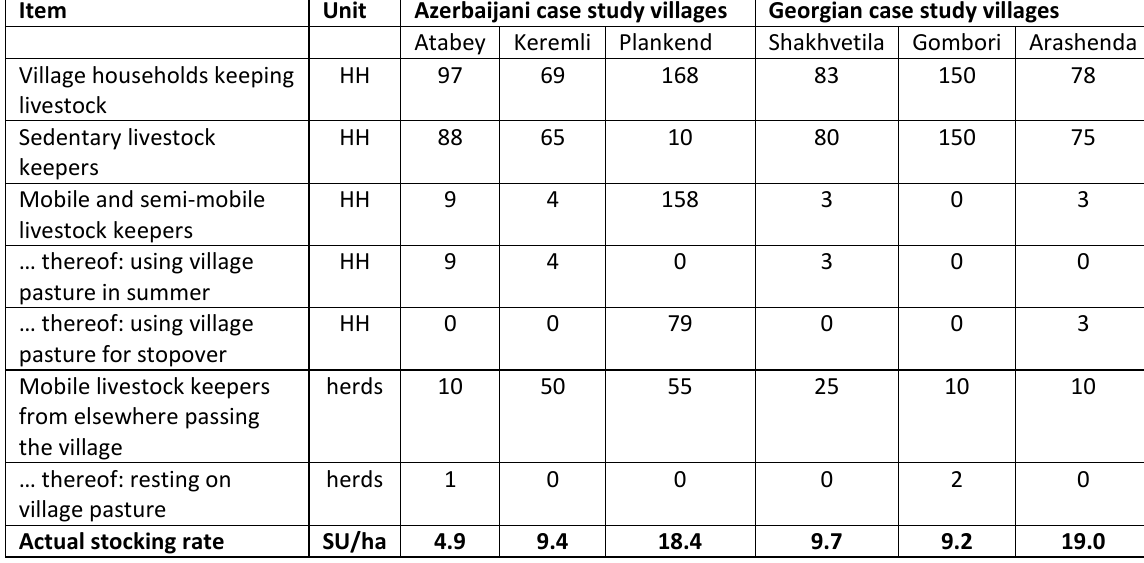
Table A2.2 Actual stocking rate